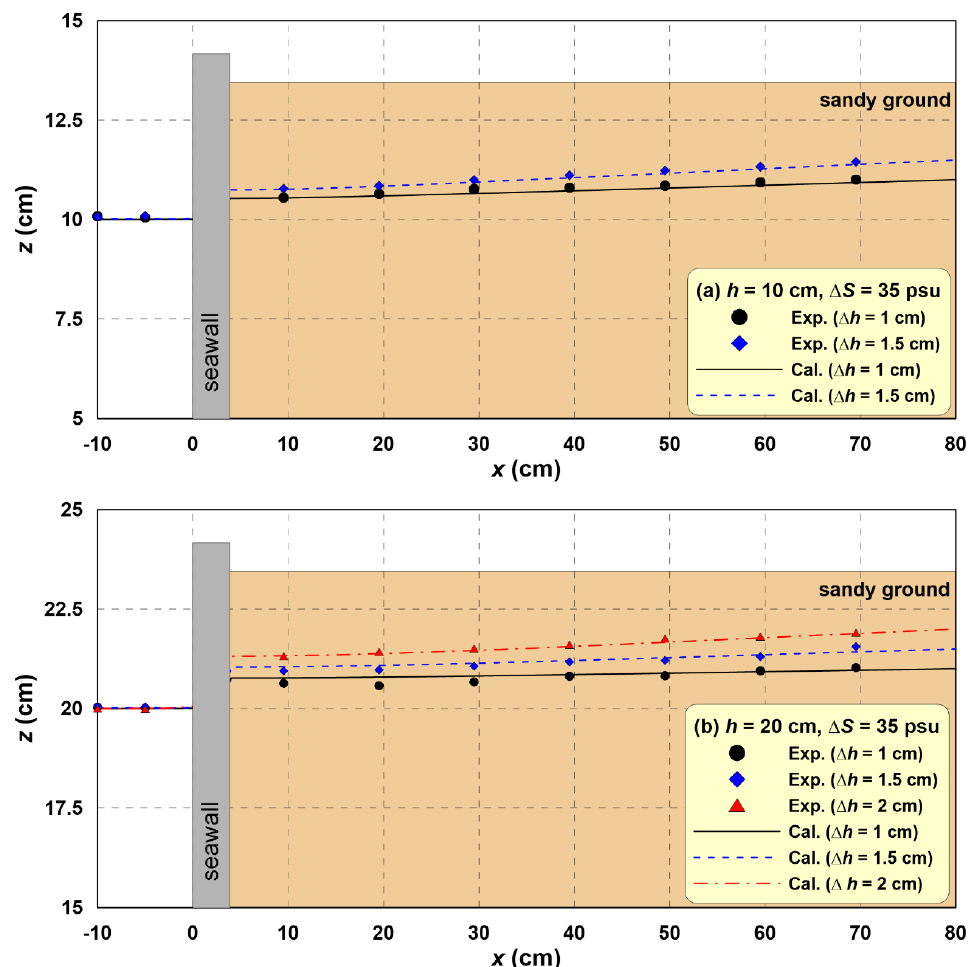
Figure 2. Groundwater tables attributable to the water level difference between saltwater and groundwater in the sandy tank for ∆ S = 35 psu at sea depths of ( a ) 10 cm and ( b ) 20 cm.